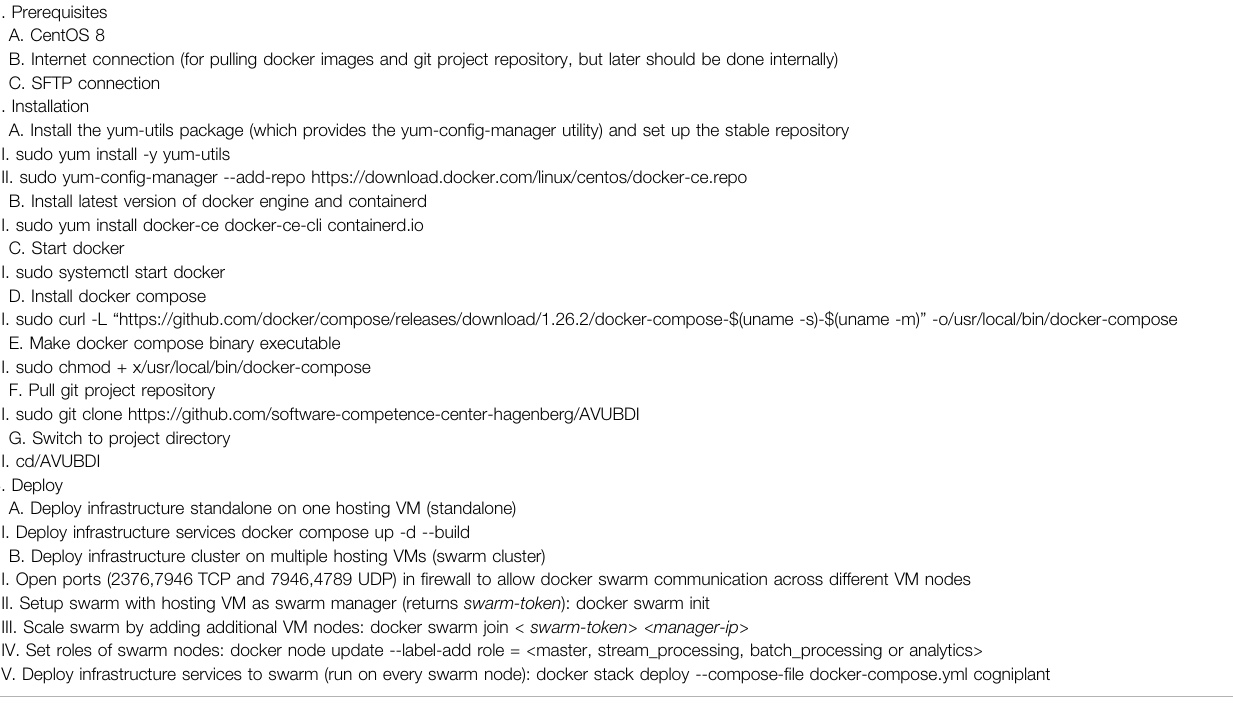
TABLE 3 | Step by step instructions for installing and deploying the AVUBDI stack on CentOS systems.